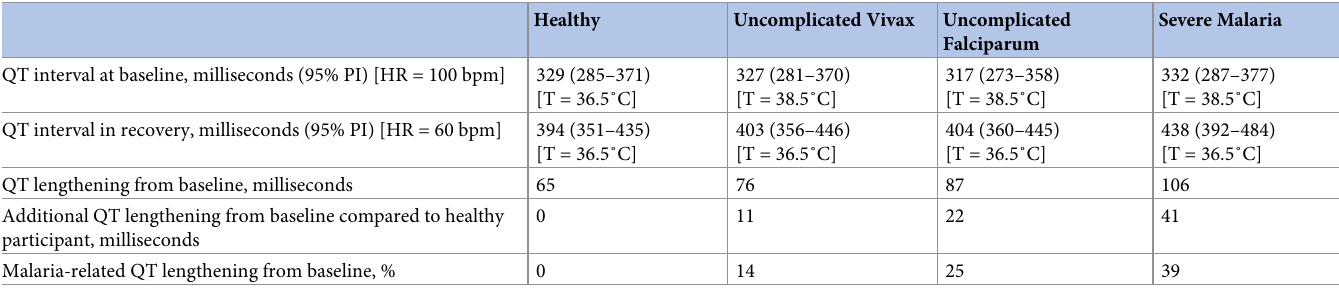
Table 3. Predicted QT intervals at baseline and in recovery from malaria and